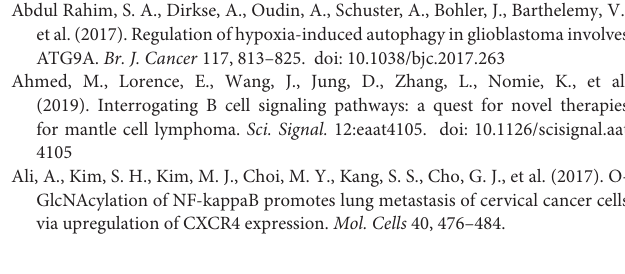
Supplementary Table 7 | Correlations of risk score with 22 kinds of TICs tested by Spearman coefficient. Supplementary Table 8 | Prognostic capacity of 22 TICs examined by Kaplan–Meier